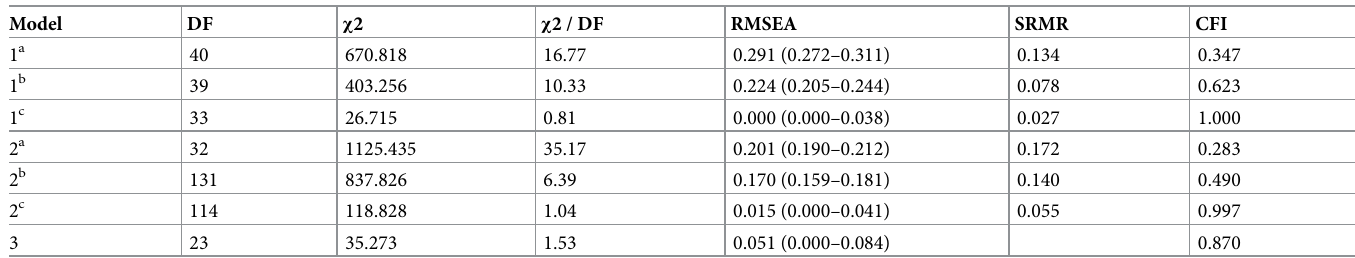
χ 2 : Chi-Square value, DF: Degrees of Freedom, RMSEA: Root Mean Square Error of Approximation, SRMR: Standardized Root Mean Square Residual, CFI: Comparative Fit